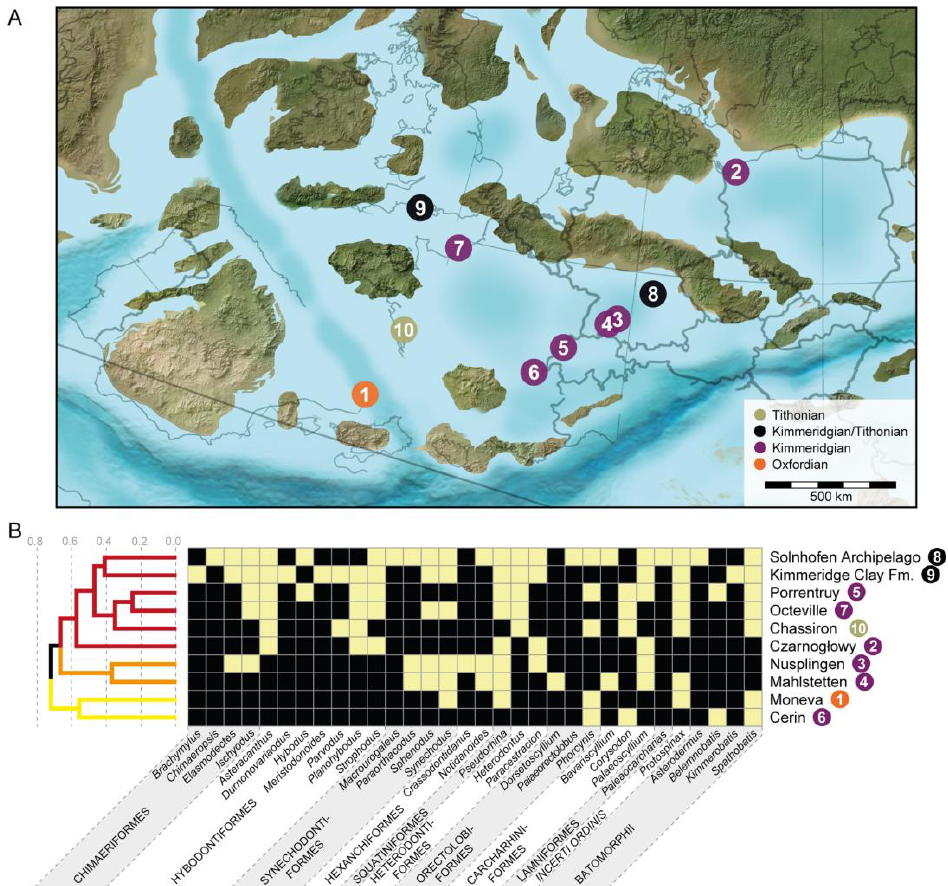
Figure 35. ( A ) Rough reconstruction of Europe during the Late Jurassic (150 Ma), depicting the position of the localities studied. Paleogeography of Europe Series © 2020 Colorado Plateau Geosystems Inc. Scottsdale Arizona. ( B ) Heat map and dendrogram showing the dissimilarity relations between geological areas based on the presence and absence of taxa. Colours in dendrogram indicate the assigned clusters in the analysis. Heat map colours: White (presence), black (absence). Numbers in the map refer to the localities in the heat map and dendrogram.